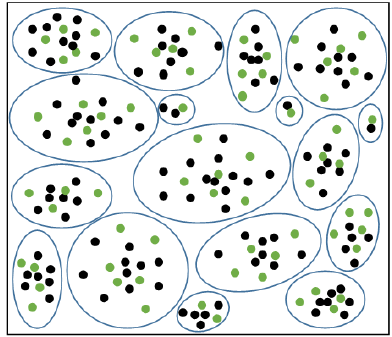
Figure 5. Schematic diagram of the undersampling process of majority samples.